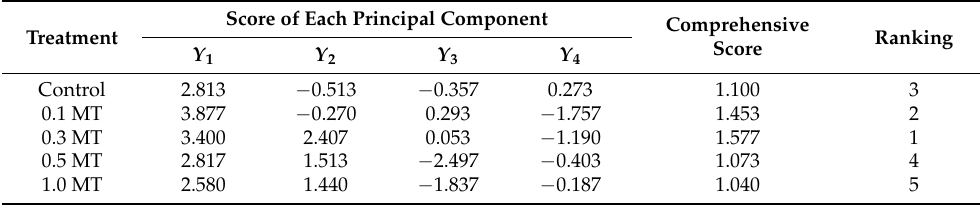
Table 5. Comprehensive evaluation results of different melatonin concentrations on postharvest kiwifruits